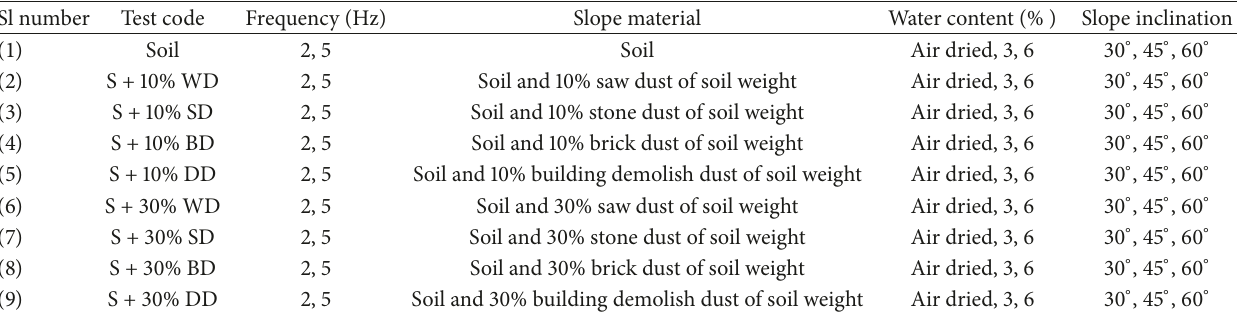
Table 2: Parameters in shaking table test of slope